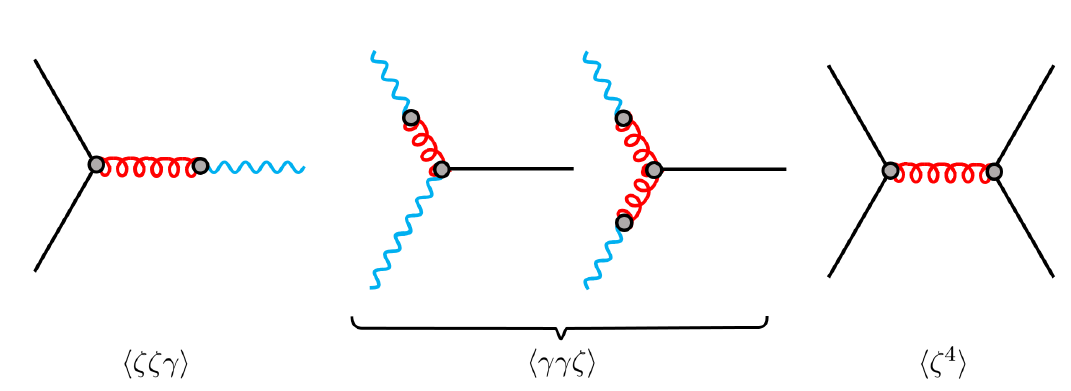
Figure 1 . Non-Gaussian correlators induced at tree level from (4.1), (4.2) and